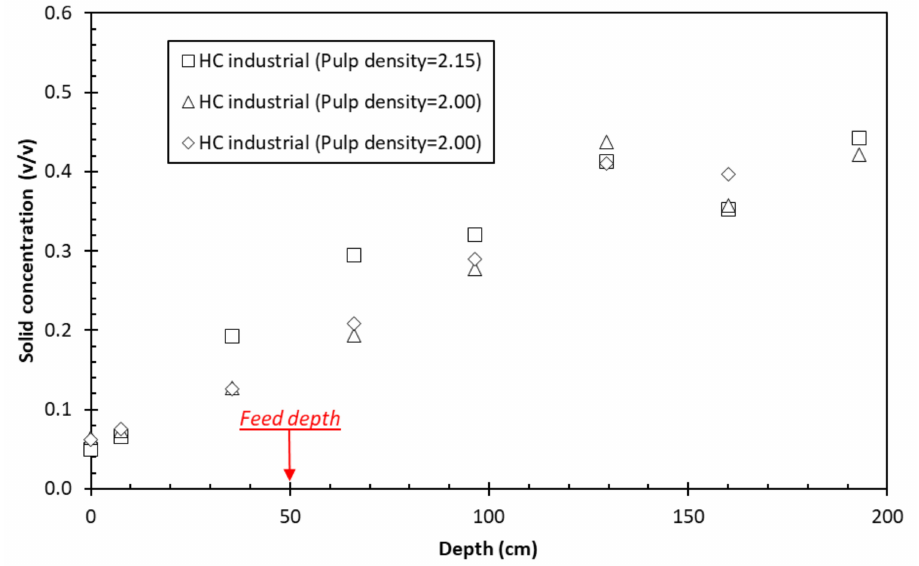
Figure 1. Concentration of solids as a function of depth for industrial